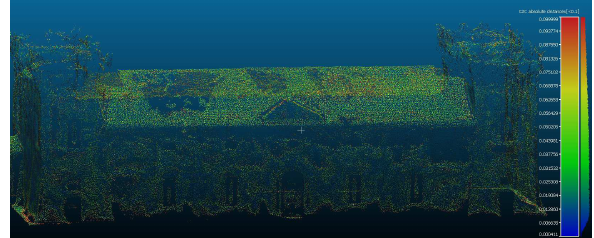
Figure 11: Comparison between photogrammetric point clouds and TLS one. Comparison made by CloudCompare (dataset 01)